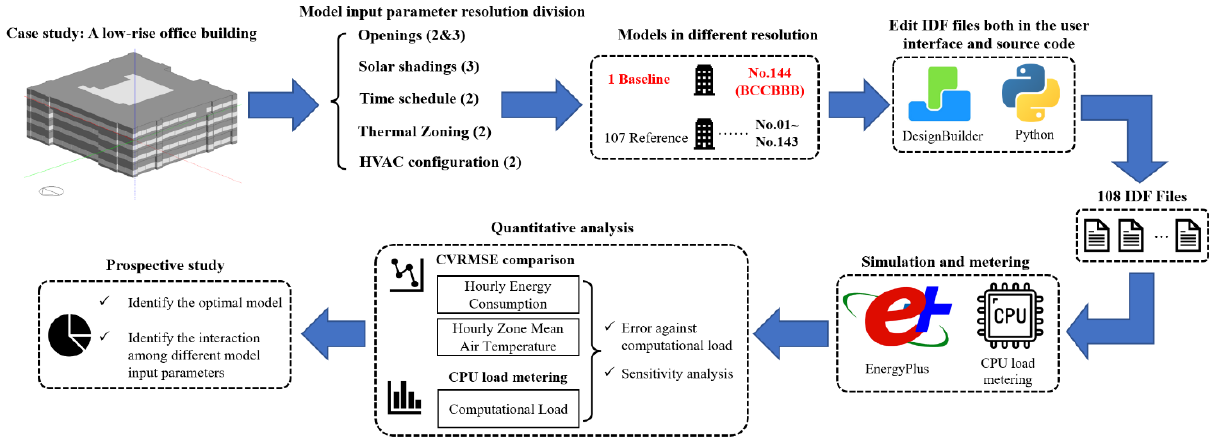
Figure 2. The workflow of this research.